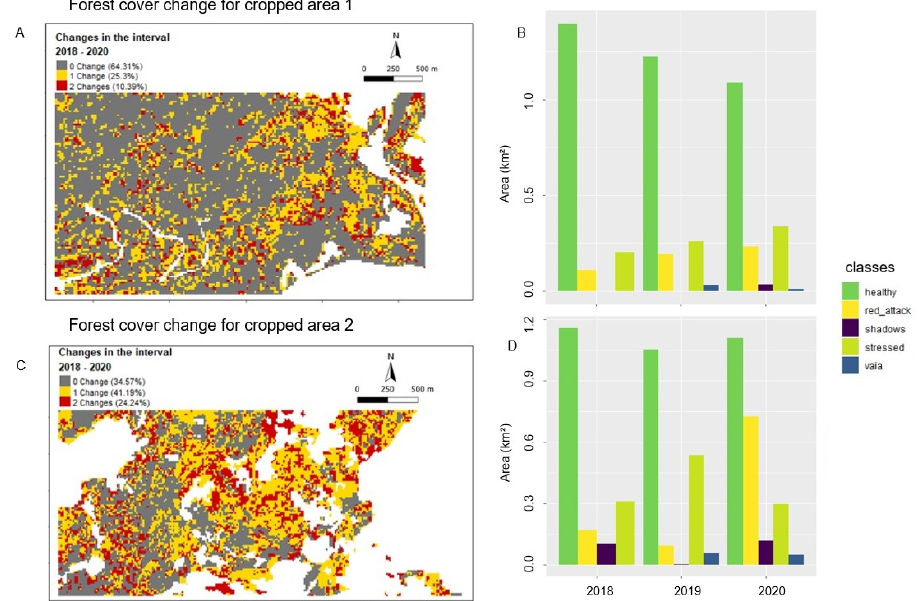
Figure 12. Forest-cover change maps in % ( A ) and ( C ) and land cover change per class in km 2 ( B ) and ( D ) for cropped areas 1 and 2 from 2018 to 2020 according to forest cover classes (healthy, red_attack, shadows, stressed and Vaia).